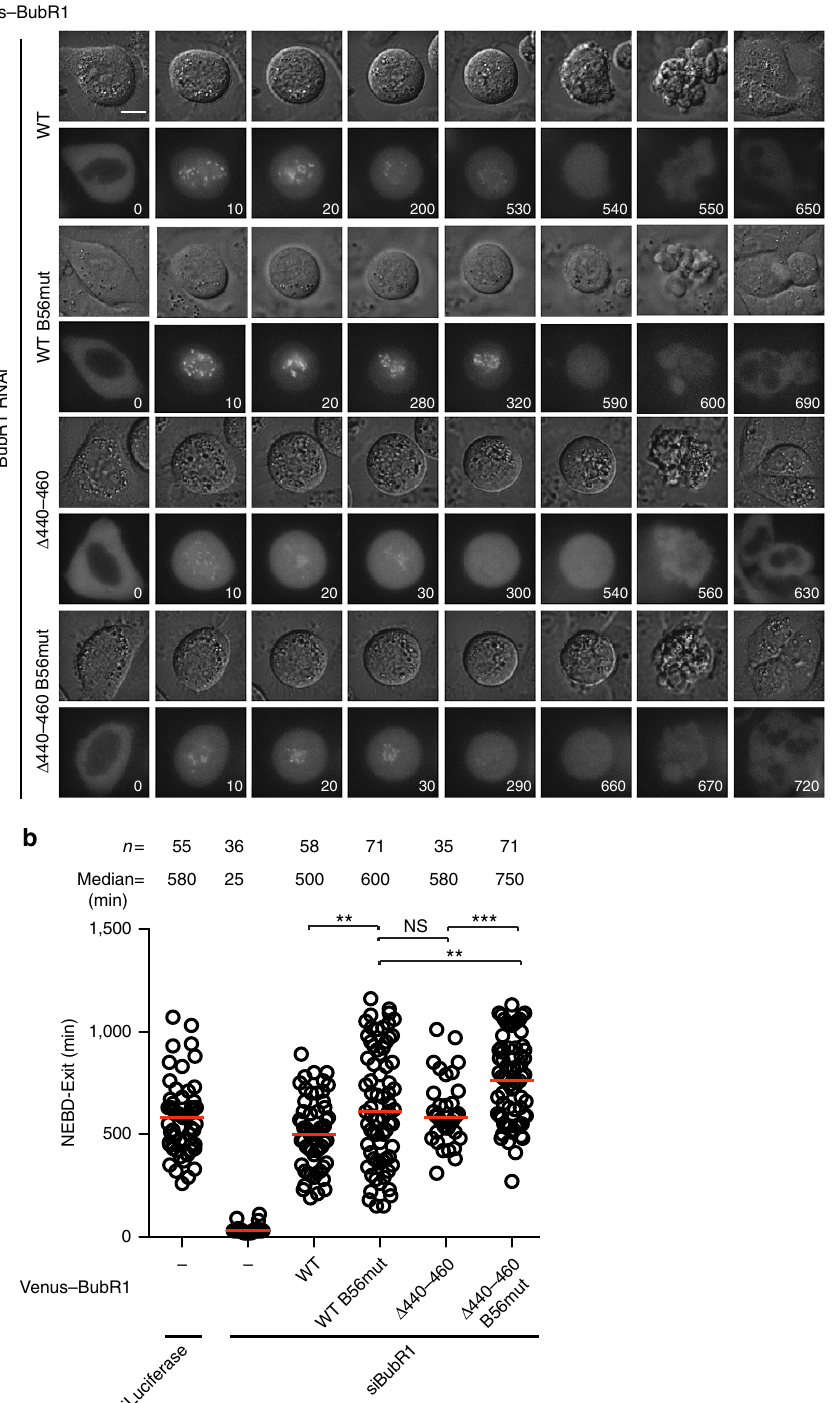
Figure 4 | Time-lapse analysis of SAC proficiency of BubR1 mutants. ( a ) HeLa cells were depleted of endogenous BubR1 by RNAi and supplemented with RNAi-resistant Venus-tagged BubR1, BubR1 B56mut, BubR1 D 440–460 or BubR1 D 440–460 B56mut plasmid. Live-cell imaging was performed to record the time cells spent in mitosis after a treatment with low dose of nocodazole. Representative still images are shown. Scale bar, 5 m m. ( b ) Quantification of the live-cell imaging results of a . n indicates the total number of cells counted. Median is the median time cells spent in mitosis which is indicated by the red line in the plot. Each dot represents a single cell. A Mann–Whitney test was used for statistical comparison of the different samples. (*** P r 0.001; ** P r 0.01; NS, not